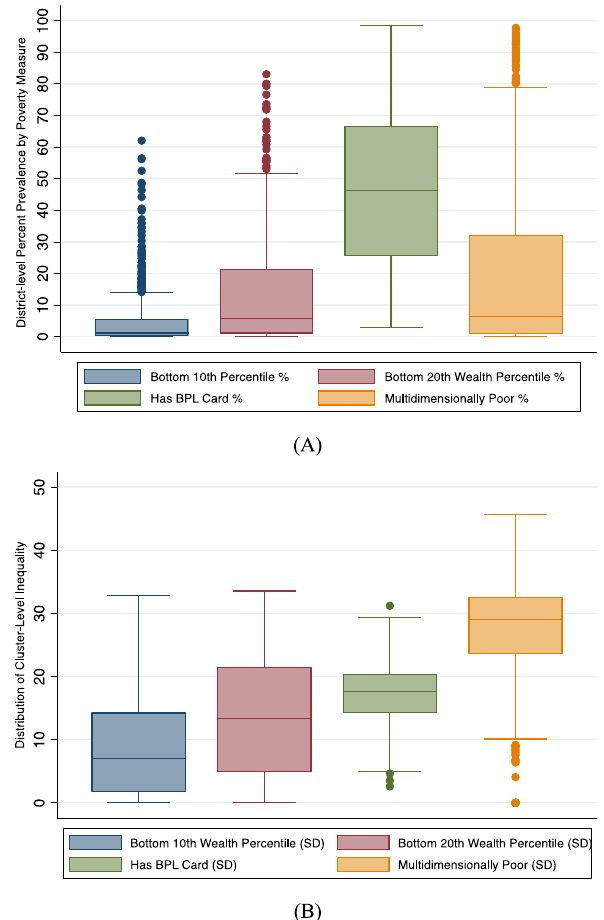
Fig. 4 Distributions of individual prevalence by poverty measure and inequality. A Box plot of district-level percent of households by each poverty measure. B Box plot of the district-level distribution of cluster-level inequality by each poverty